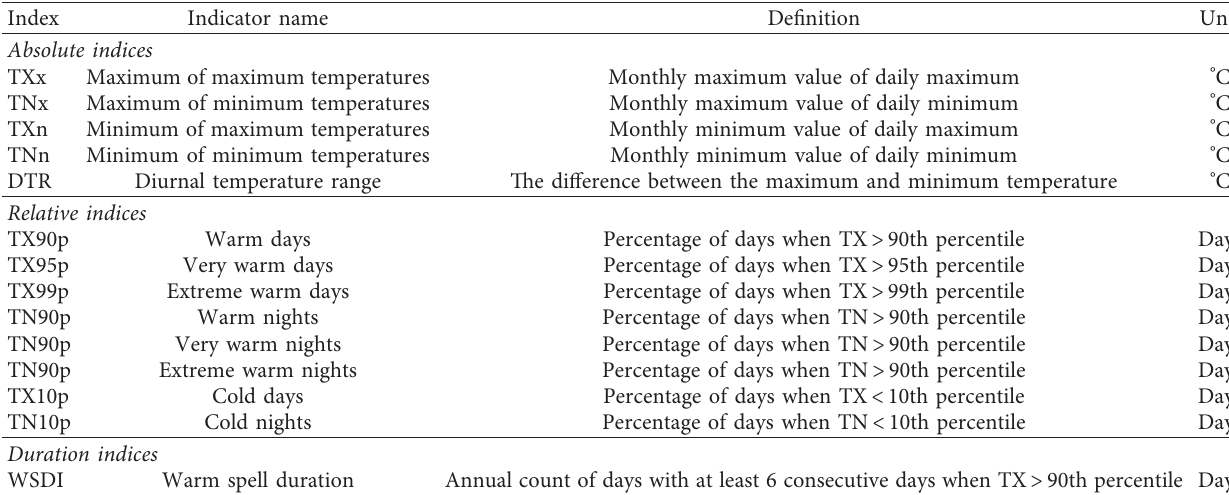
Table 2: List of extreme indices recommended by the expert team on climate change detection and indices (ETCCDI) used in this